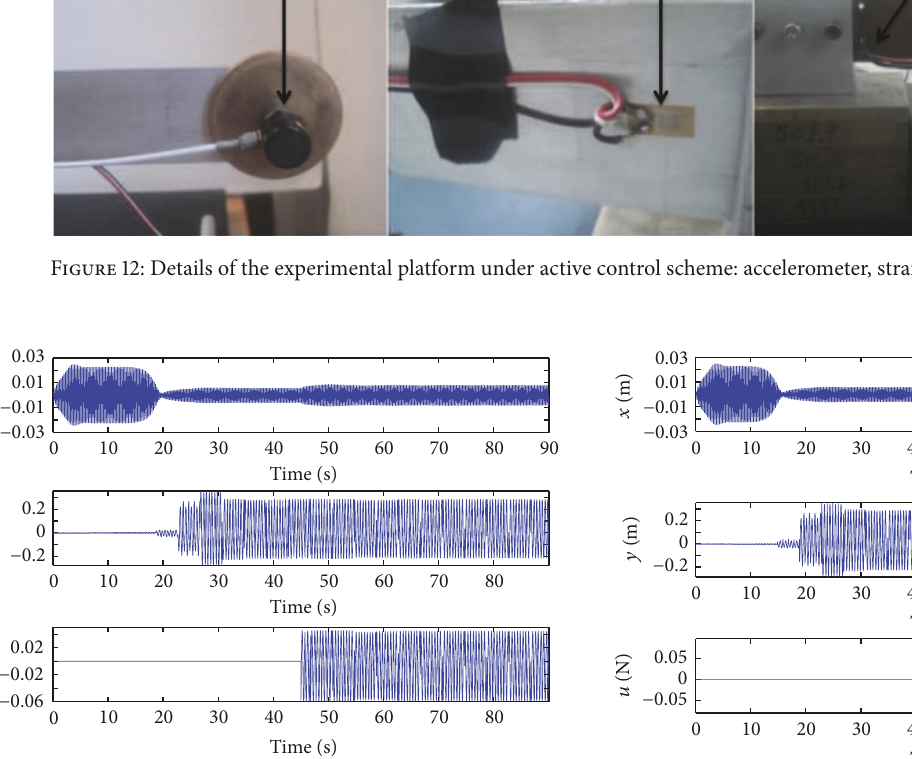
Figure 14: Dynamic response of the primary system, with autopara- metric interaction, using the passive/active beam absorber and PZT actuator switching the stiffness feedback exactly at the frequency change ( 𝜀𝜌 1 = −0.2